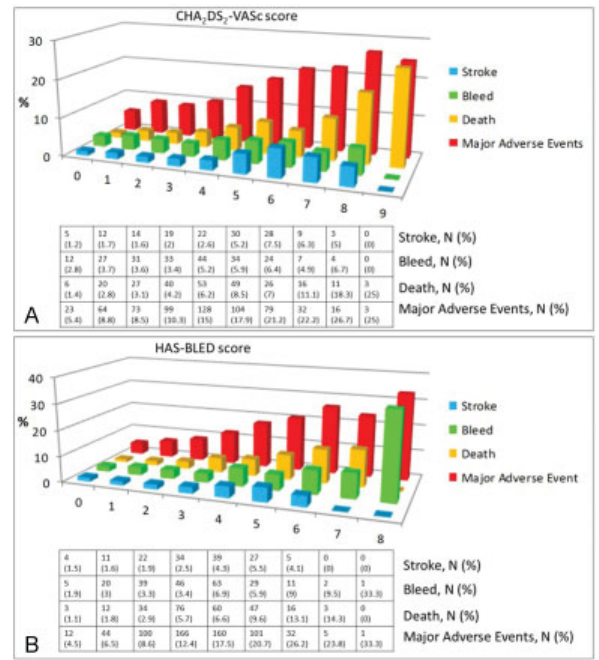
Fig. 1 Frequency (%) of adverse events in patients with atrial fi brillation (AF) by CHA 2 DS 2 -VASc score ( A ). Frequency (%) of adverse events in patients with atrial fi brillation (AF) by HAS-BLED score ( B ).